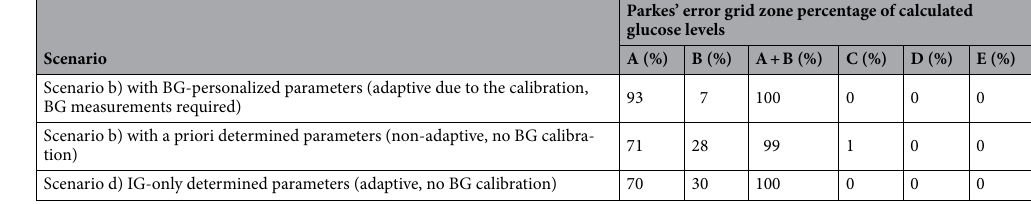
Table 5. Parkes’ error grid for diabetes type-1; calculating BG with All IG signals. Note as the Scenario d), with IG-only determined parameters, reduced the C-zone percentage as an improvement to the initial, a priori